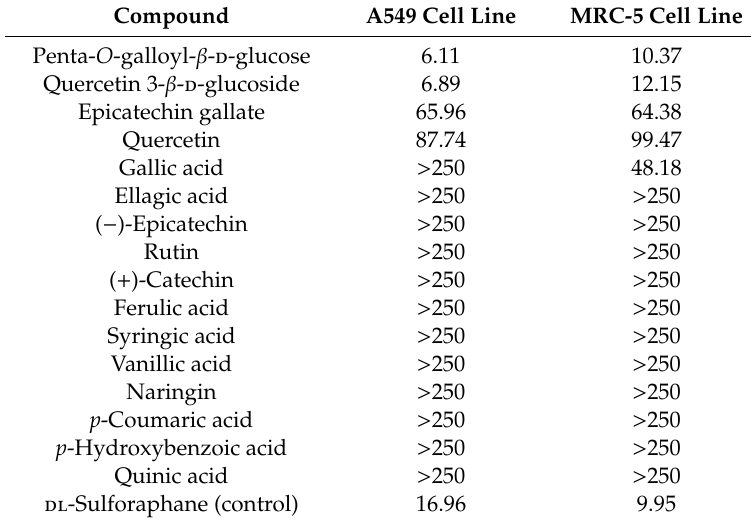
Figure 2. Antioxidant response element (ARE) activation activities of the tested compounds in HepG2-ARE cells. In the heatmap, color represents relative fold-increases in ARE activities in HepG2-ARE cells treated with DMSO and compounds compared with the corresponding vehicle control, the HepG2-ARE cells treated with 0.35% DMSO only. * Penta- O -galloyl- β - d -glucose was screened at concentrations of 0, 2.5, 15, 30, 80, 125, 175 µ M, respectively. Table 2. Half maximal inhibitory concentrations (IC 50 ) of phenolic compounds ( µ M) in black walnuts in A549 and MRC-5 cell